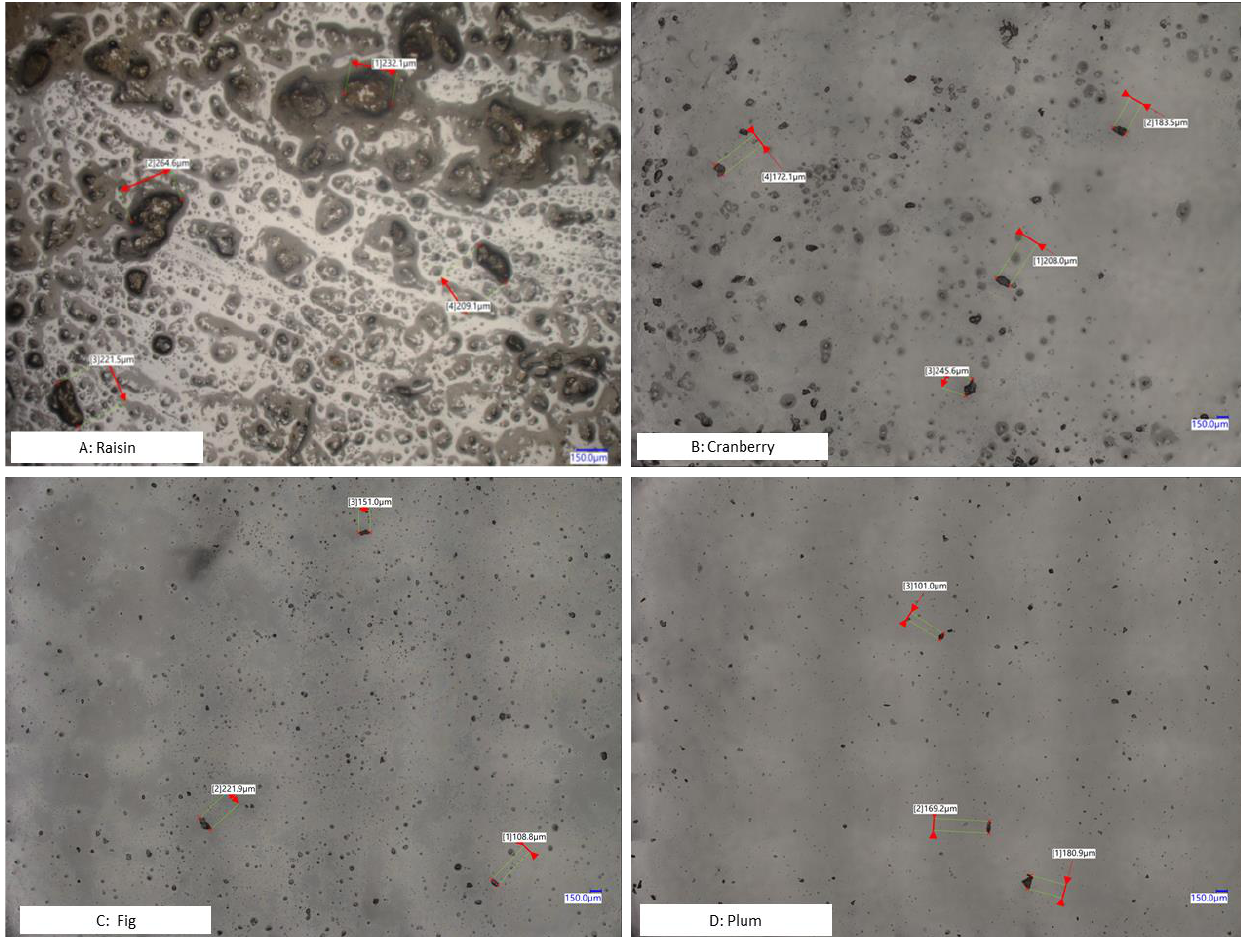
Figure 1. Microscopic images (Digital Microscope, Keyence VHX-7000 Series) of dispersed dried fruit samples prepared using cryo-milling.